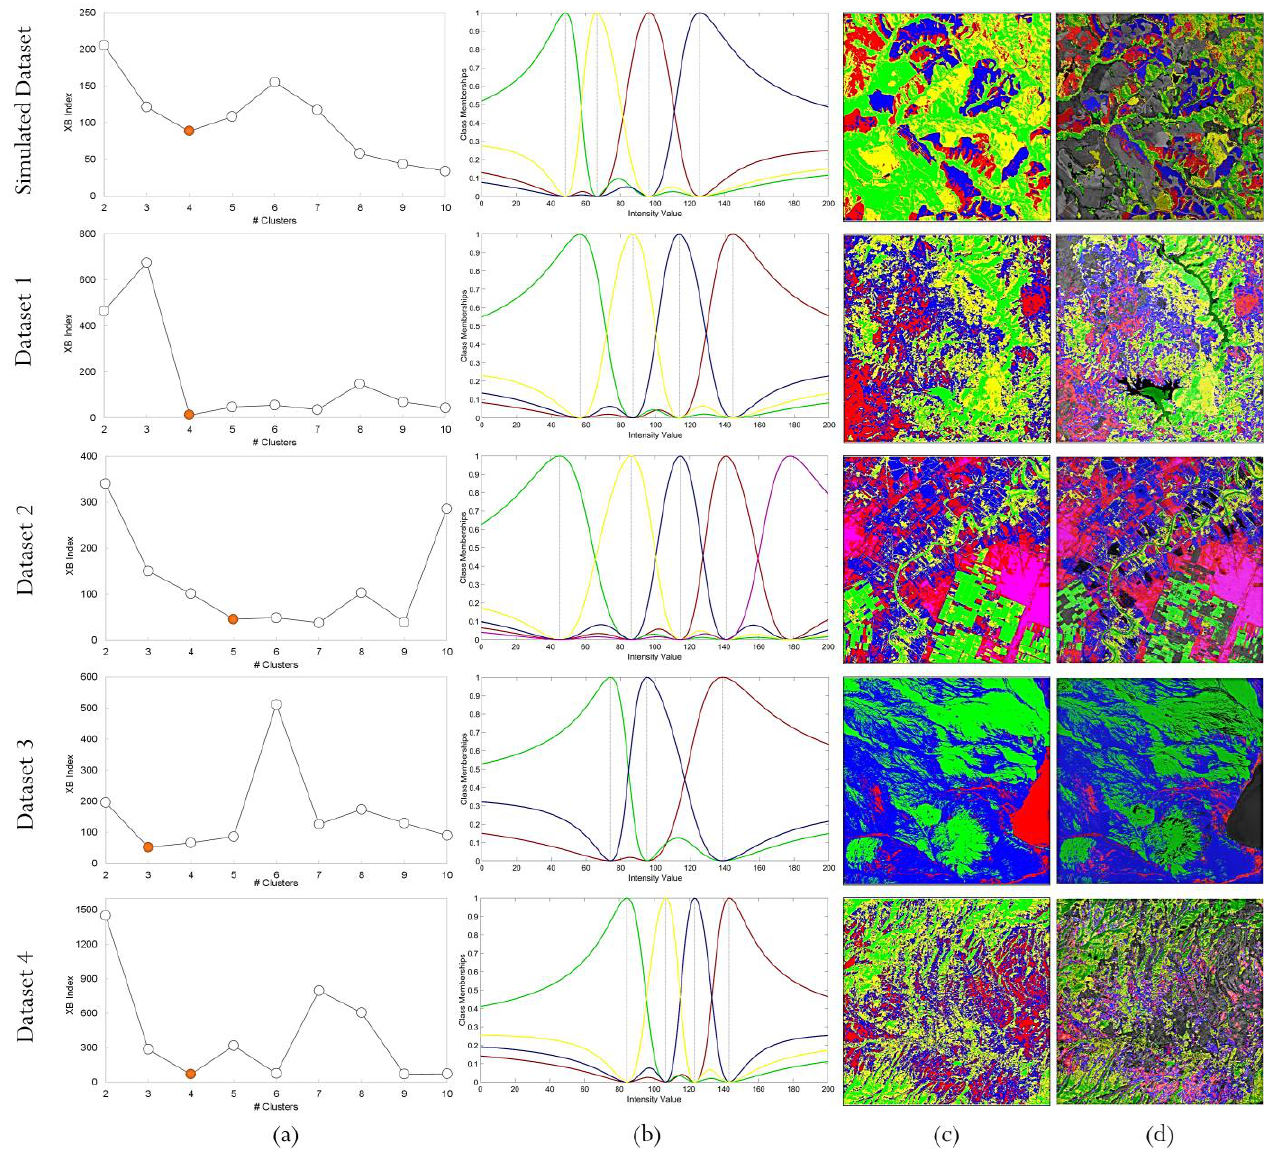
Figure 4. ( a ) The optimal cluster number selection through the HFCM clustering using the XB index for all datasets. ( b ) Membership function maps, ( c ) clustering results for all datasets, and ( d ) clustered PIFs extracted by the proposed coarse-to-fine strategy for all datasets.